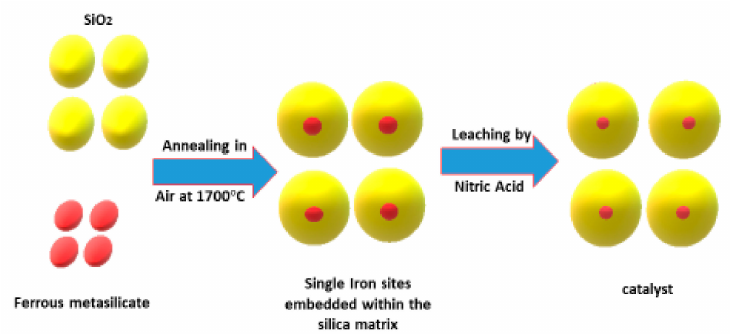
Figure 16. The preparation steps of the fused